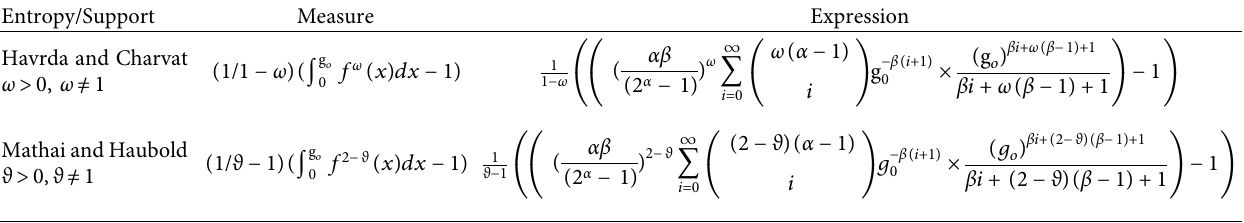
Table 2: The final expressions for Havrda and Charvat, and Mathai and Haubold entropy measures. Entropy/Support Measure Expression